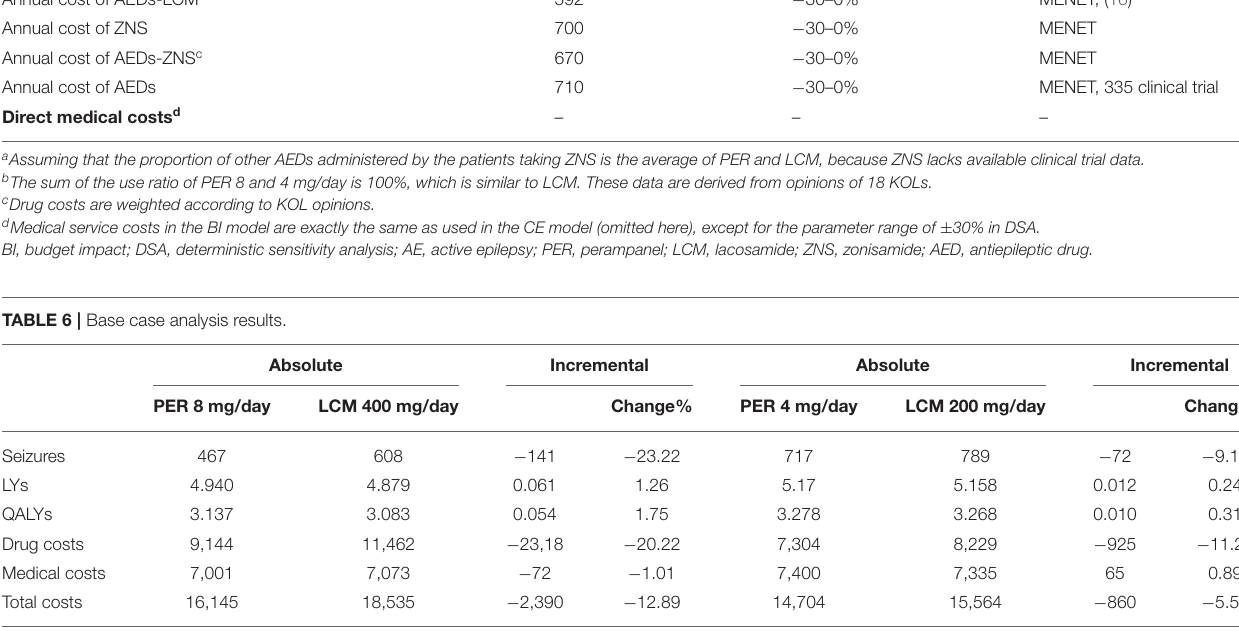
Supplementary Table 4 . For the two groups of daily doses, we obtained the use ratio of clinical patients for different daily